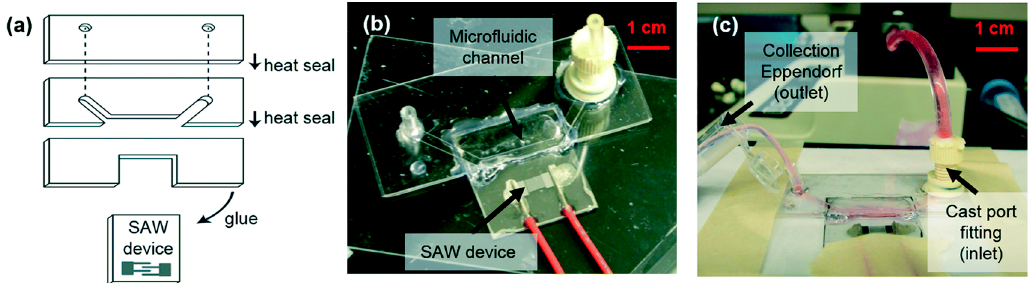
Figure 12. Surface acoustic wave (SAW) lysis microfluidic device: ( a ) assembly of device; and ( b , c ) as fabricated device with liquid inlet and outlet for exosome lysis. Reproduced with permission from [77].